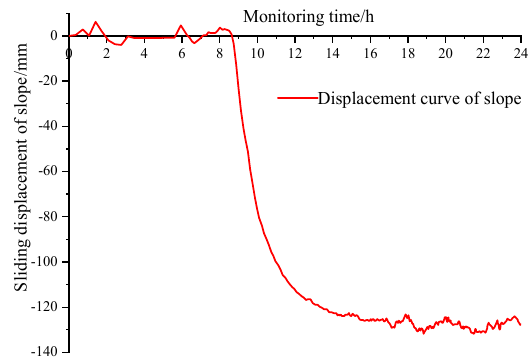
Figure 8. Energy evolution process of slope system in Washan pit.